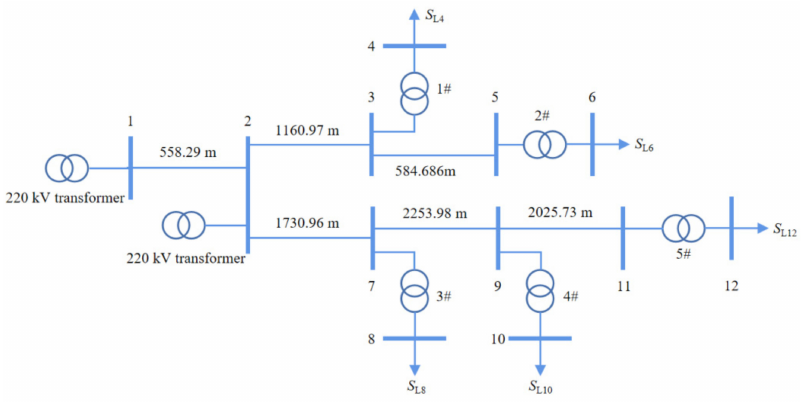
Figure 5. One-line diagram of the power supply network with 110 kV.